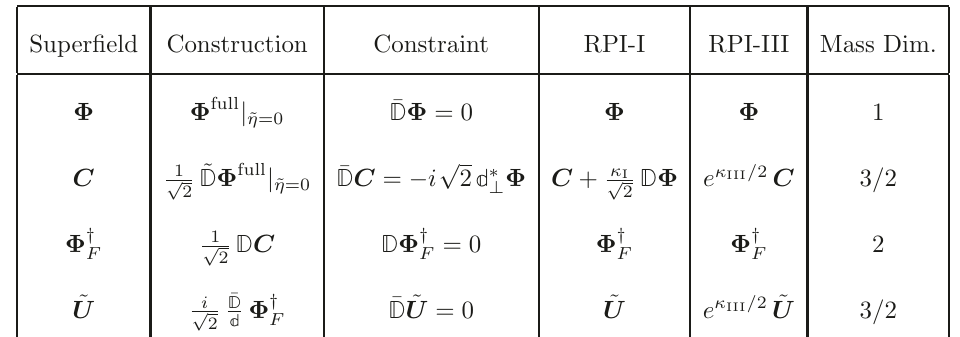
Table 3 . Collinear superfields for chiral matter, along with their top-down construction, con- straints, and symmetry properties. Note that RPI-II is omitted since it is only well-defined at the level of components. The RPI-I and RPI-III charges of a superfield are inherited from its lowest